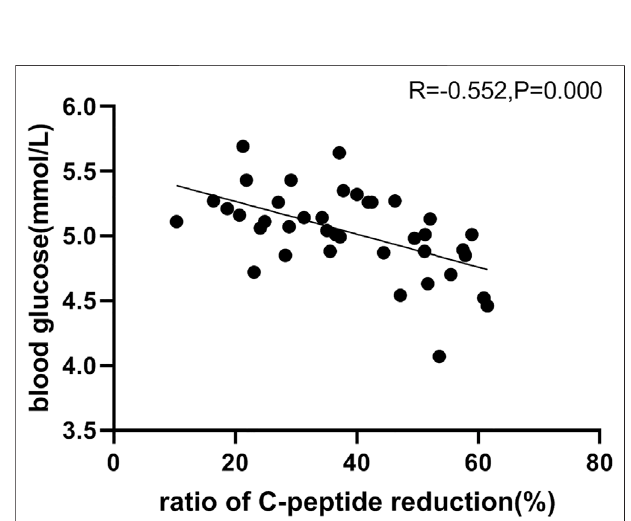
FIGURE 1 | Mean C-peptide concentration versus time pro fi les after 0.4 IU/kg doses of glargine insulin in healthy volunteers. The error bars represent the 95% con fi dence intervals. The extent of C-peptide reduction in group C was apparently higher than that in the others, and there were statistically signi fi cant differences among groups.